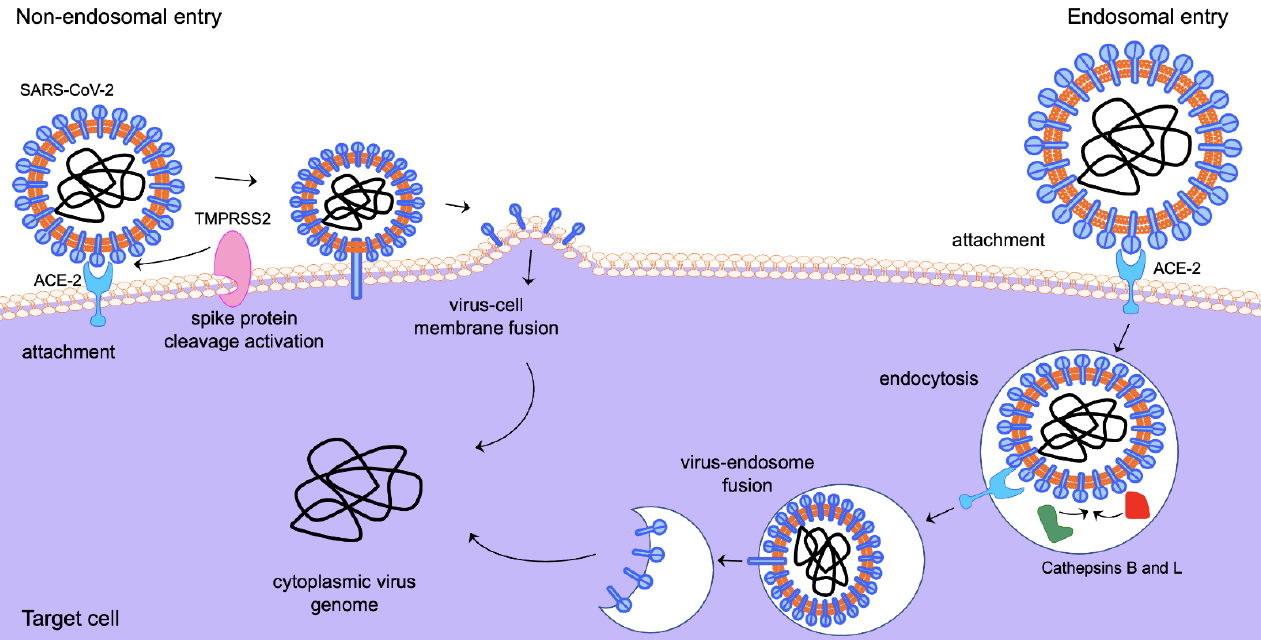
Figure 1. Alternative entry routes of SARS-CoV-2 into target cells. Elements of the schematic are from Motifolio.